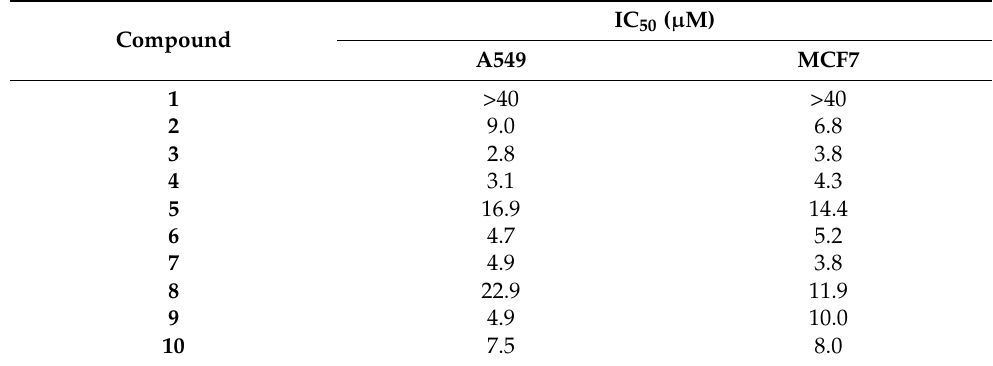
Table 9. The in vitro cytotoxicity of glycyrrhetinic acid conjugates with esters in the C-3 position against cancer cell lines. ( 1 ) Glycyrrhetinic acid; ( 2 ) cisplatin; ( 3 ) glycyrrhetinic